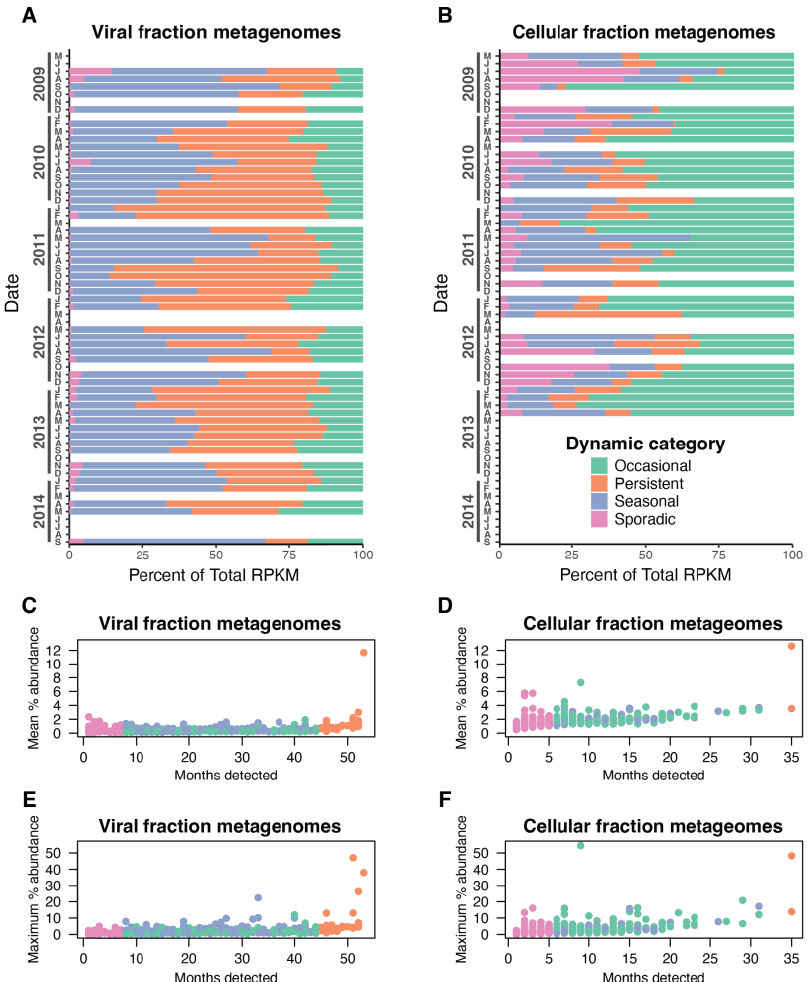
Figure 4. The contribution of species to the T4-like cyanophage community. ( A , B ) Cumulative abun- dances of cyanophages in each dynamic class in viral (<0.2 µ m) ( A ) and cellular fraction metagenomes (0.2–1.2 µ m) ( B ) as determined by read mapping (RPKM). Results are shown sequentially for each month, with blank lines indicating no data for that month. ( C , D ) The average percent contribution of each cyanophage species across all time points when present vs. the number of times that vi- ral species was detected (“Months detected”) in ( C ) viral and ( D ) cellular fraction metagenomes. ( E , F ) The maximum percent abundance of each species relative to total T4-like cyanophage abundance across all viral ( E ) and cellular ( F ) fraction metagenomes. In ( C – F ), each point represents a distinct cyanophage